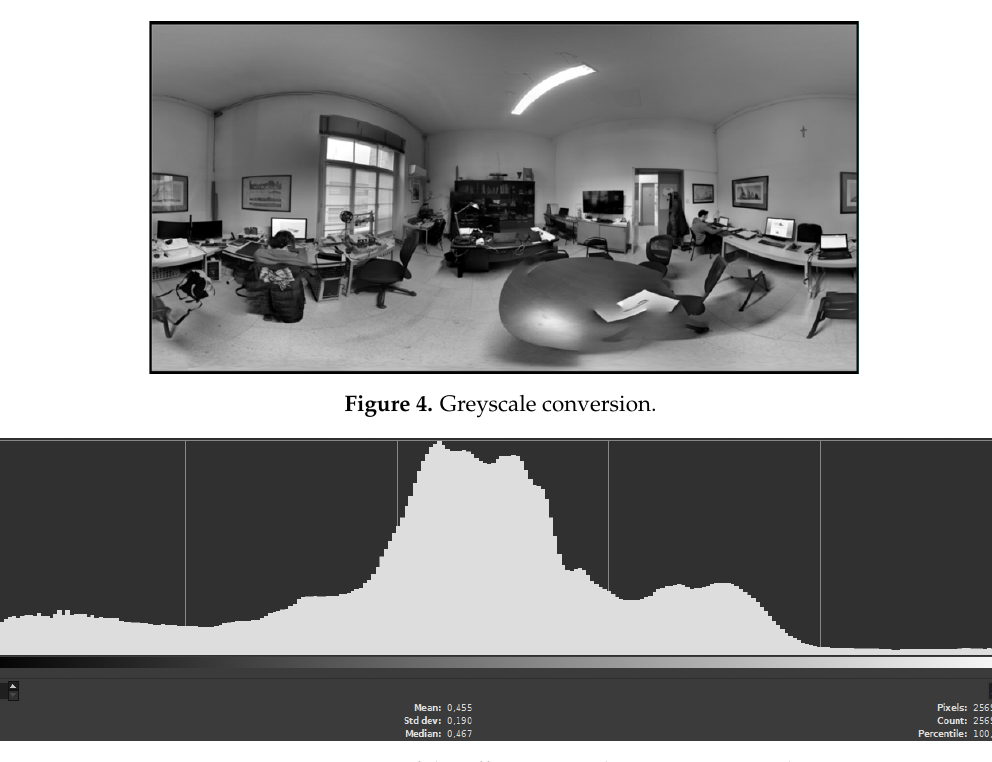
Figure 5. Histogram of the office room sphere map case study.